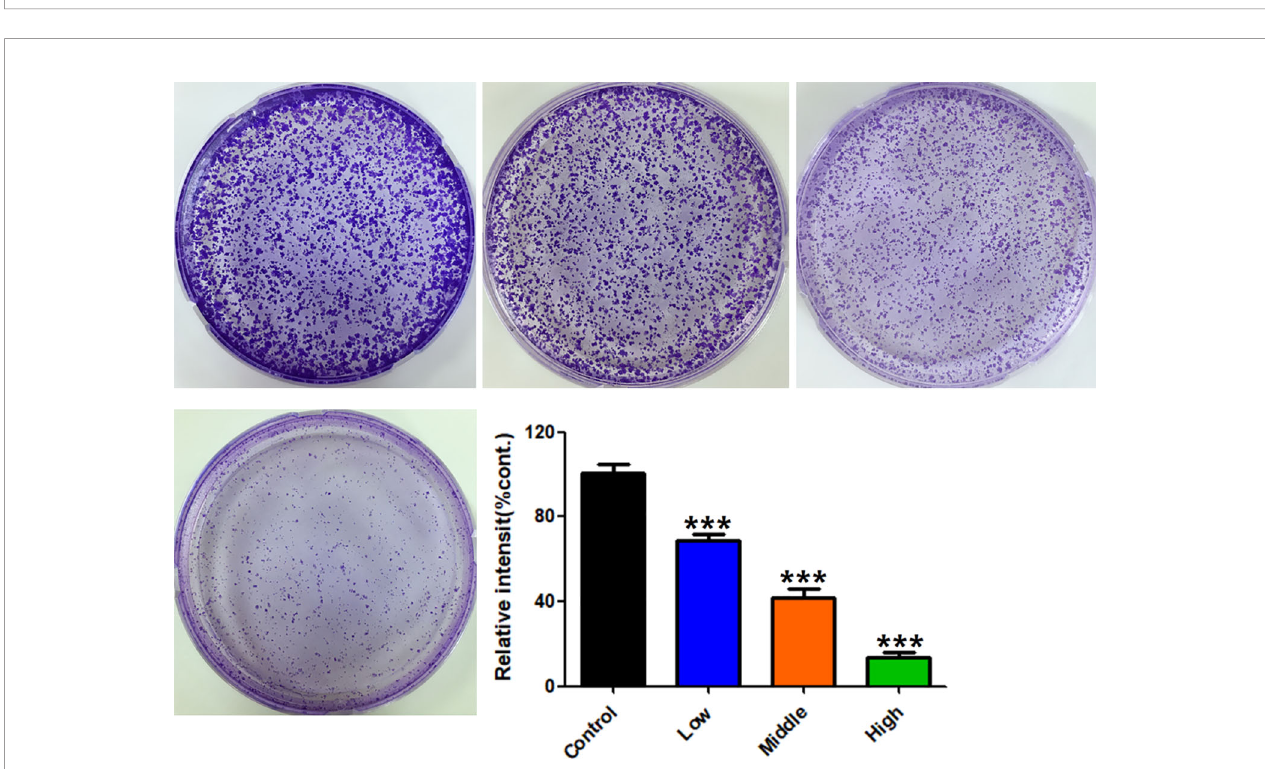
FIGURE 8 | Effects of RPL on cloning formation of A549 cells. Cells were treated with RPL (0.2, 0.4, and 0.6 mg/mL) for 14 days and then stained with crystal violet. The colony formation was observed under a microscope, and fi ve fi elds were randomly selected for counting. Data were expressed as mean ± SD (n = 3), and asterisk indicated signi fi cant difference, *** p < 0.001 vs. control.